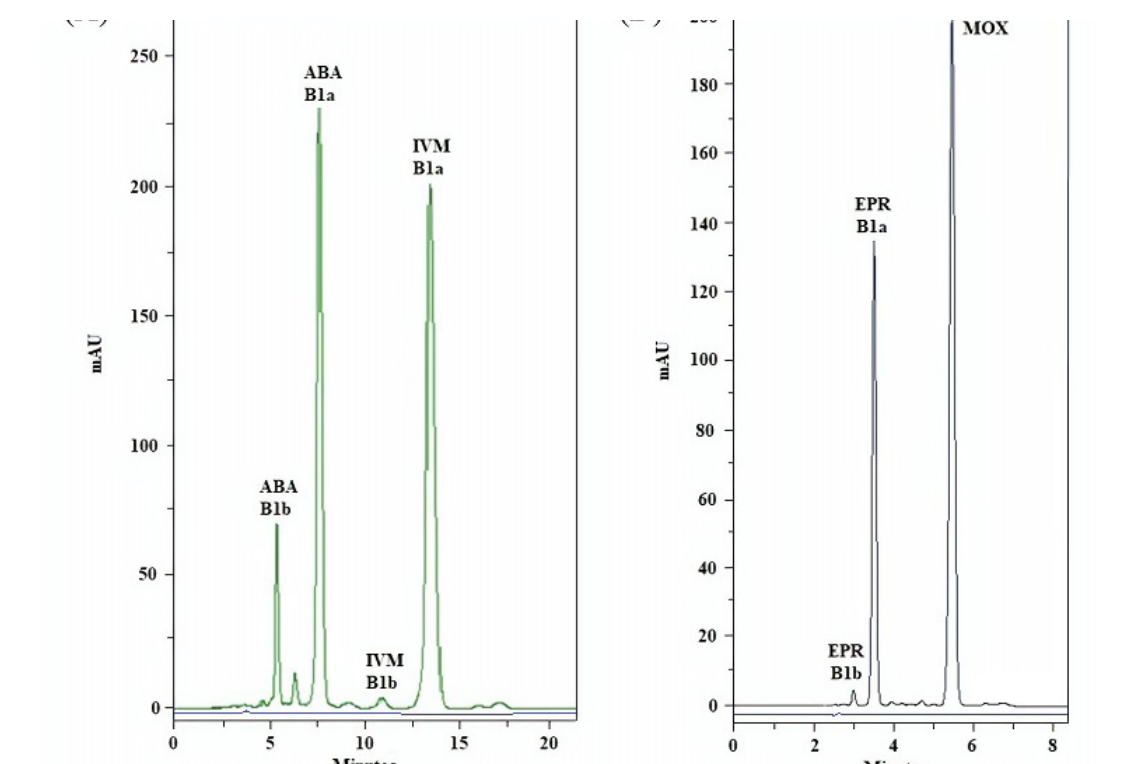
FIGURE 1 - Optimized chromatograms referring to analysis of (a) ABA B1b and ABA B1a, IVM B1b and IVM B1b; and (b) EPR B1b and EPR B1a, and MOX. Chromatographic conditions: mobile phase of acetonitrile: methanol: ultrapure water (53: 35: 12, v/v/v) and acetonitrile: ultrapure water (87: 13, v/v), respectively, Phenomenex ® Gemini C18 column